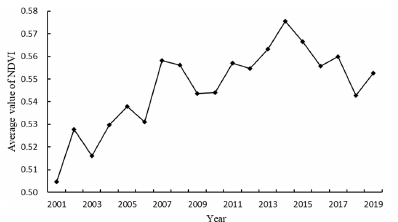
Figure 3. Annual variation of NDVI in Anhui Province from 2001 to 2019.